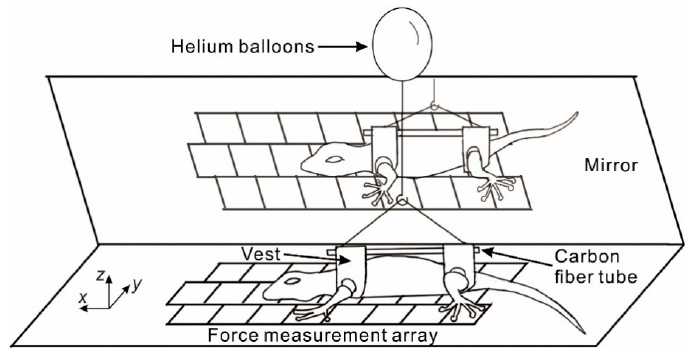
Figure 1. Schematic of the set-up used to study single leg and toe reaction forces of the gecko. The gecko was put on the force platform consisting of 3 × 8 measurement arrays. Helium-filled balloons were used to balance the animal’s body weight. Note that the balloon and connecting thread are not drawn to scale.